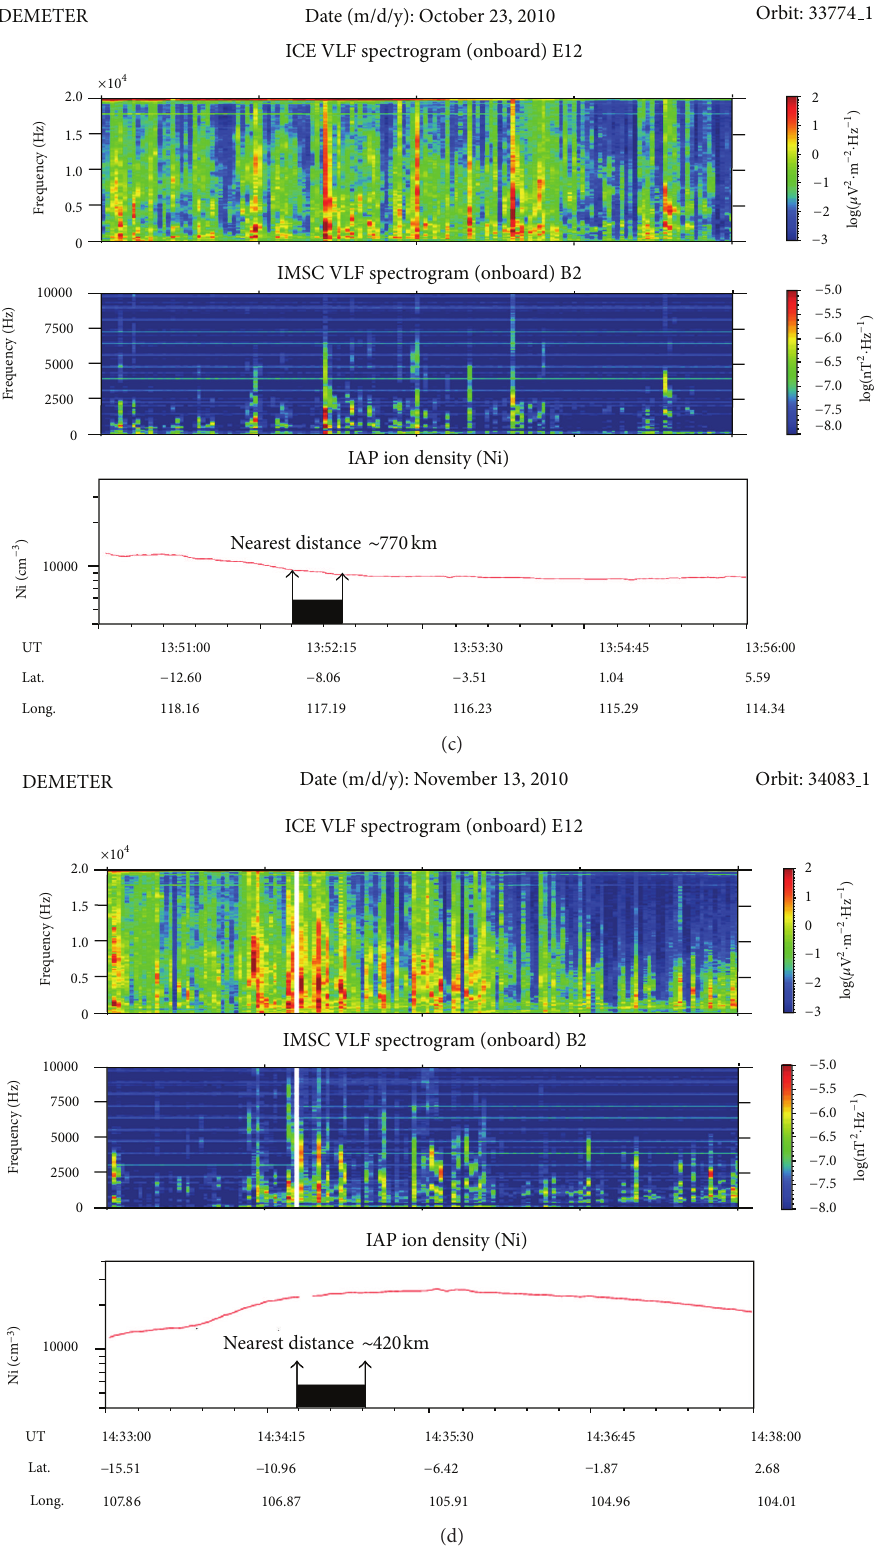
Figure 9: Examples of ionospheric anomalies (electric and magnetic fields and ion density) related to Merapi October 26, 2010, eruption.